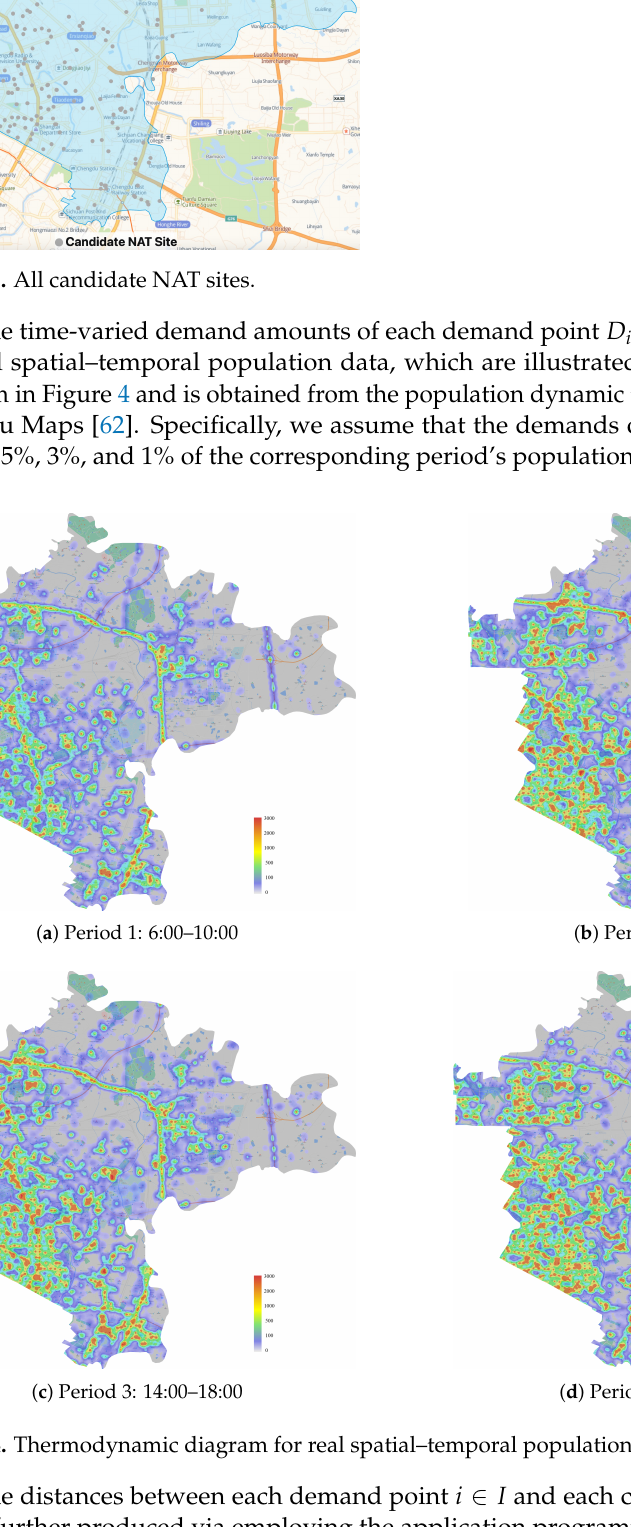
Figure 4. Thermodynamic diagram for real spatial–temporal population data in Chenghua District. The distances between each demand point i ∈ I and each candidate NAT site j ∈ J